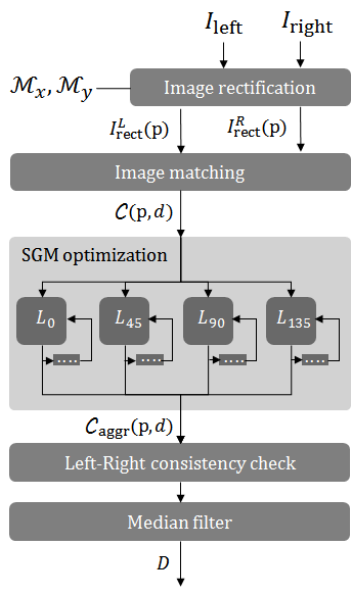
Figure 2. Schematic overview of our processing pipeline for real- time disparity estimation of a FPGA. Within the SGM optimiza- tion the costs are aggregated along 4 concentric paths, i.e. L 0 - horizontal from left to right, L 45 - diagonal to bottom right, L 90 - vertical from top to bottom, L 135 - diagonal to bottom left. The aggregation costs are buffered in order to accumulate them while iterating of the image